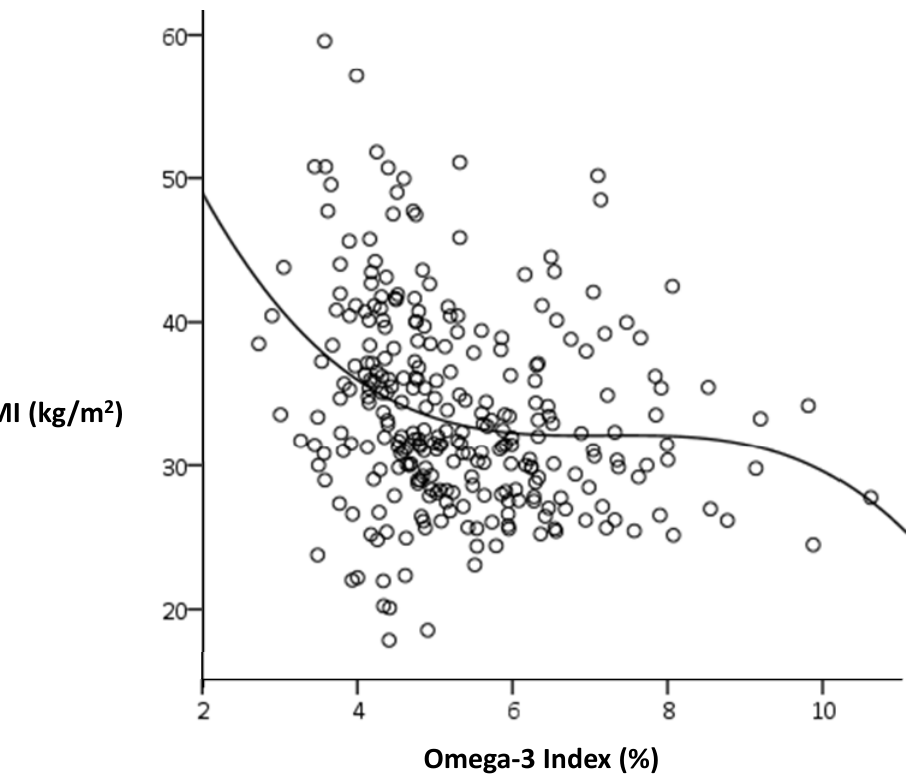
Figure 2. Sigmoidal relationship between BMI and the Omega-3 Index in